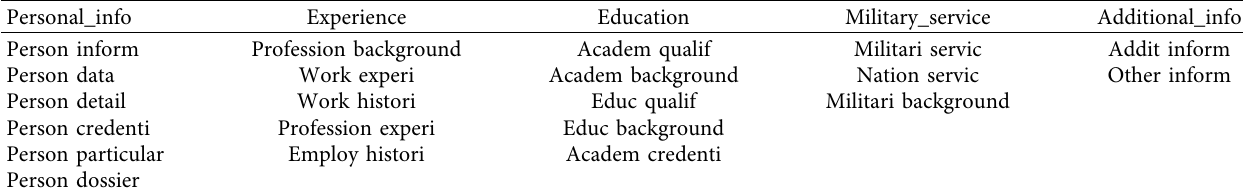
Table 1: Collection of cue phrases used by the algorithm.